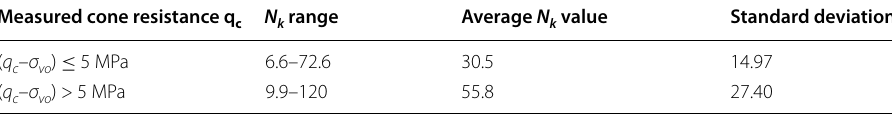
with measured ( q k